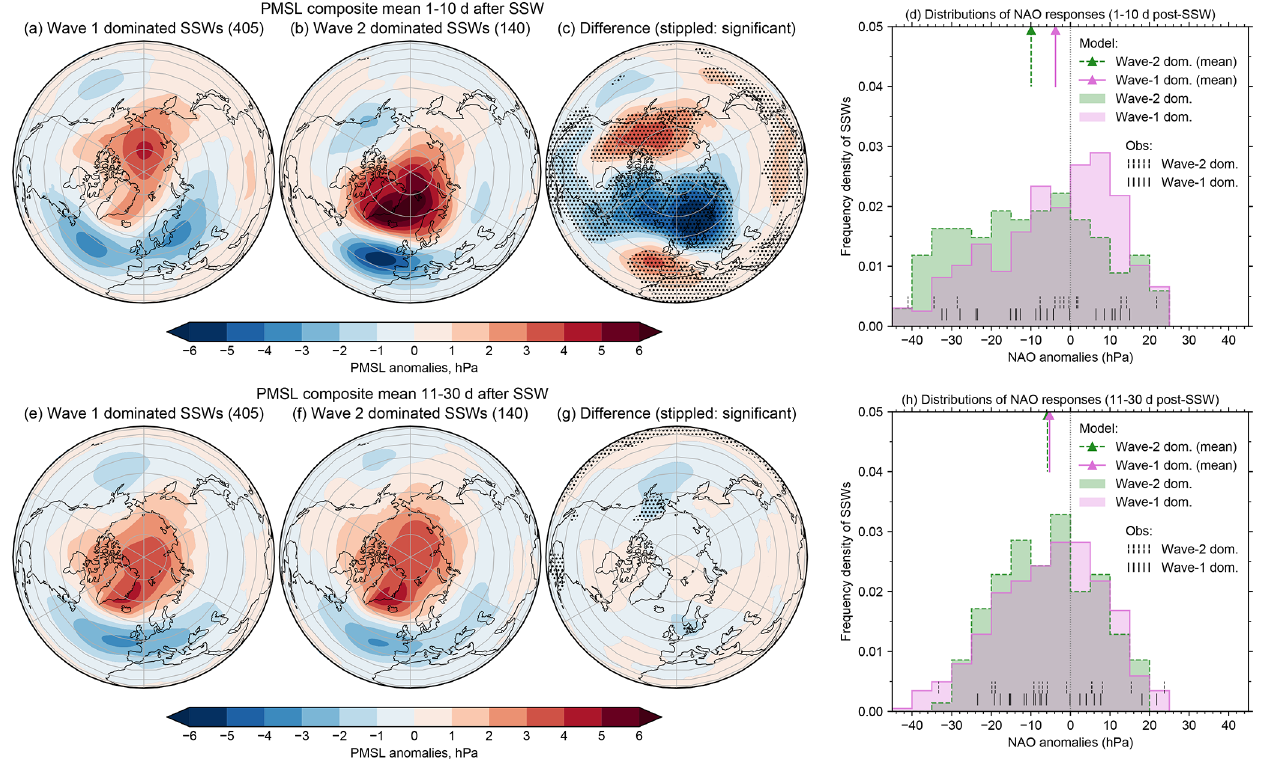
Figure 8. Surface responses to wave-1- and wave-2-dominated SSWs for the first 10d (top row, panels a–d ) and days 11–30 (bottom row, panels e–h ) after the SSW. The maps (panels a–c and e–g ) show the composite mean PMSL anomalies for wave-1- and wave-2-dominated cases, as well as the difference between the two, as in Fig. 7. The histograms (panels d and h ) show the distributions of NAO anomalies over wave-1- and wave-2-dominated SSWs, as in Fig.